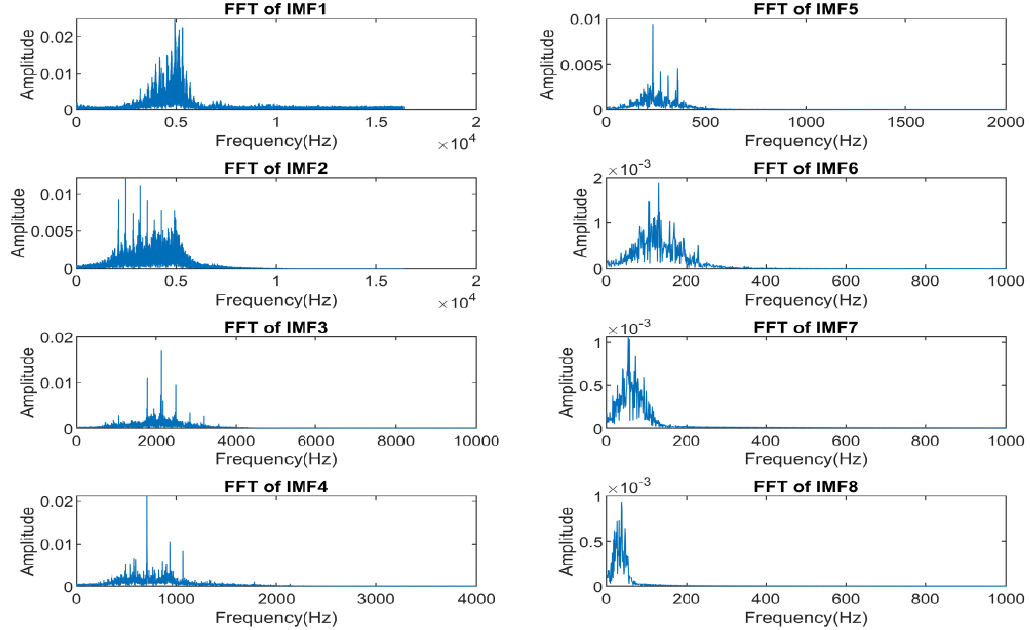
Figure 5. The corresponding FFTs of individual IMFs.